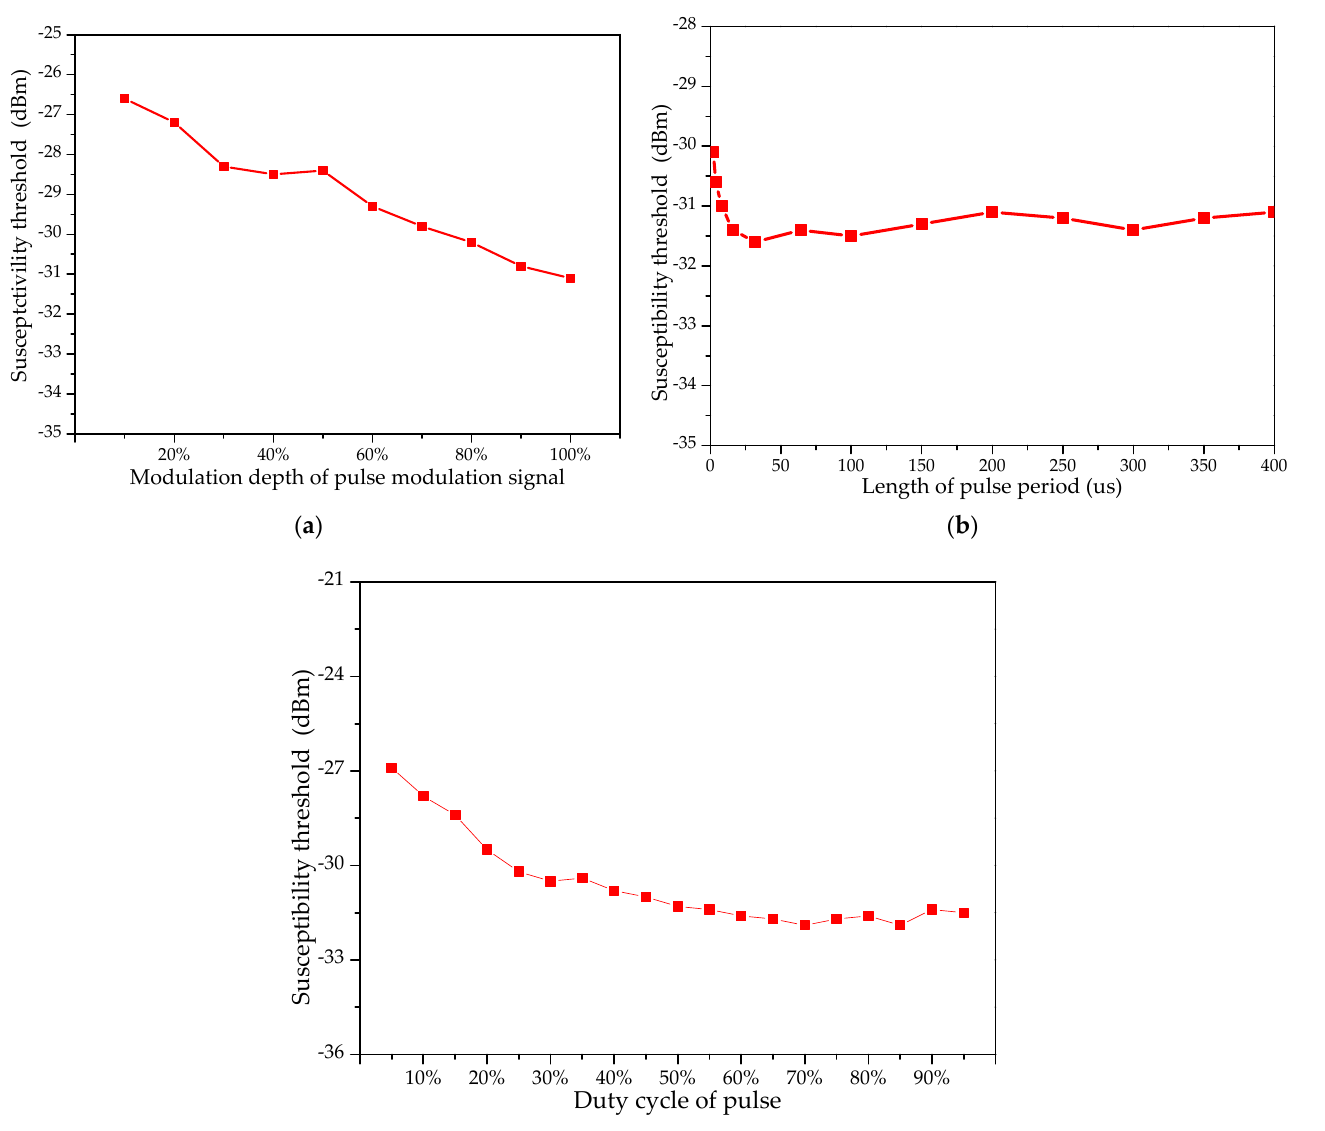
Figure 8. The susceptibility threshold curve of the laser ranging system under pulse AM modulation interference: ( a ) under different modulation depths; ( b ) under different pulse periods; ( c ) under different pulse duty cycles.